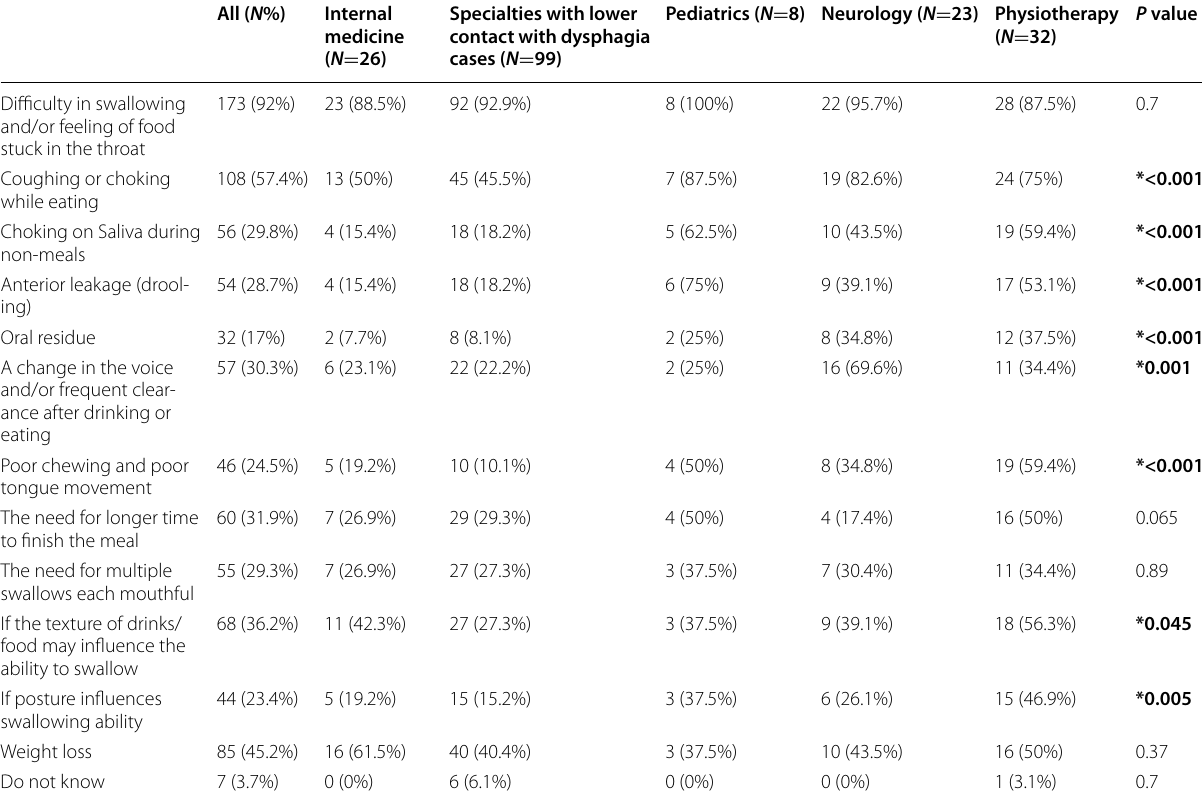
Table 3 The percentages and comparison among the participants in different specialties regarding their responses about the indicative symptoms and signs of